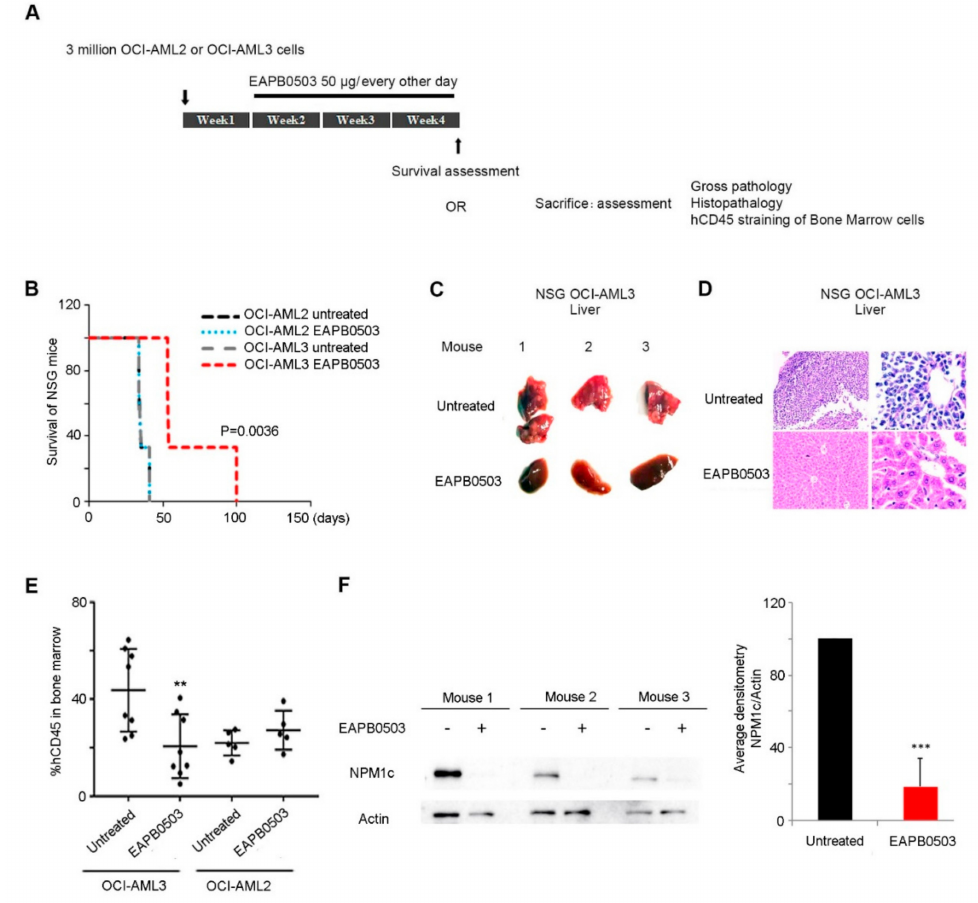
Figure 1. EAPB0503 prolongs survival and attenuates AML pathological features in NPM1c AML xenograft NSG mice. ( A ) Eight-week-old NSG mice were injected with 3 million OCI-AML2 or OCI- AML3 cells intravenously (12 mice per cell line per condition). After 1 week post injection, EAPB0503 (2.5 mg/kg, 50 µ g/mouse) was intraperitoneally administered every other day, for a total period of 3 weeks. At the end of week 3, one group of six mice per condition was monitored for survival. The remaining six mice per condition were sacrificed for gross pathology, histopathology and hCD45 staining on the flushed bone marrow cells. ( B ) Kaplan–Meier overall survival of untreated NSG mice injected with OCI-AML2 or OCI-AML3 (n = 6, black line and gray line, respectively) or